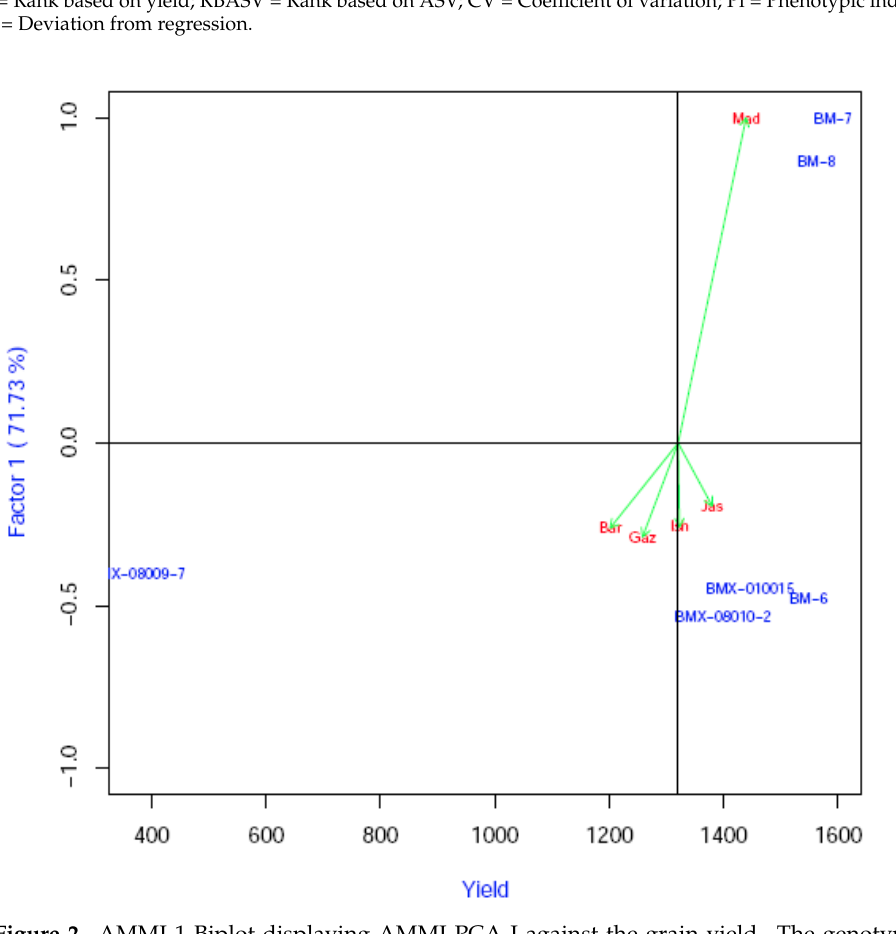
Figure 2. AMMI 1 Biplot displaying AMMI PCA I against the grain yield. The genotypes BM-6, BM-7, and BM-8 stand for BARI Mung-6, BARI Mung-7, and BARI Mung-8, respectively, and the environments Ish, Gaz, Jas, Bar, and Mad stand for Ishurdi, Gazipur, Jashore, Barishaland Madaripur, respectively.